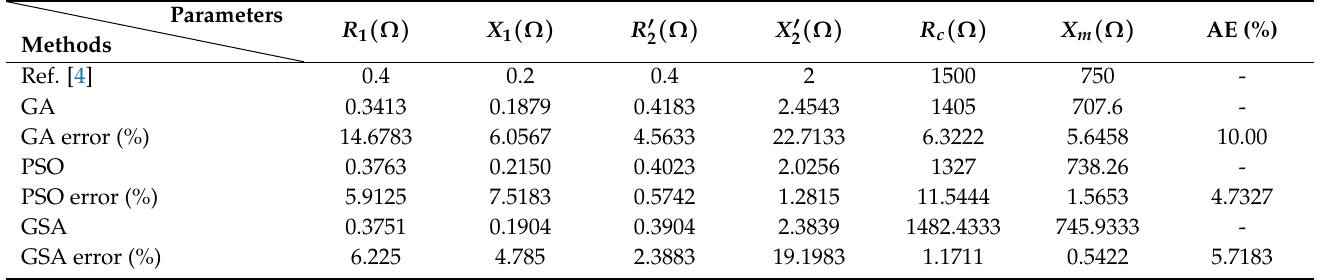
Table 2. Parameters obtained with the optimization methods for the single-phase transformer 4 kVA, 250–125 V at 50 Hz.